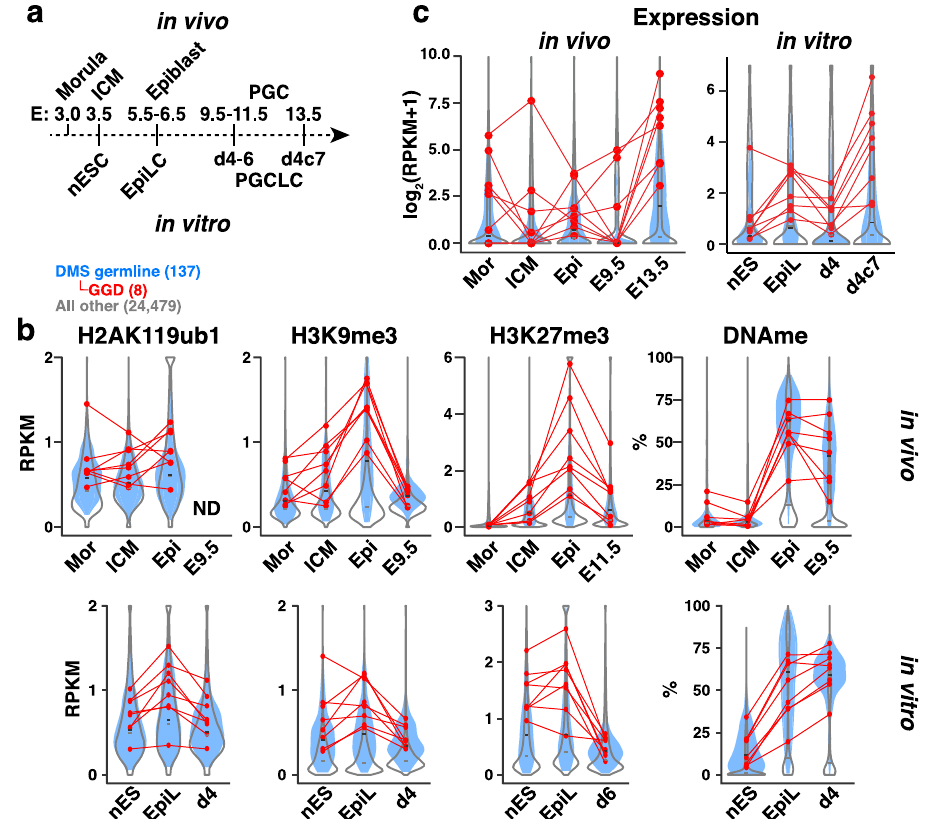
Fig. 3 H2AK119ub1 and H3K9me3 precede DNAme at DMS germline genes during embryonic development and EpiLC induction. a Application of an in vitro differentiation system to model pre-implantation (ICM), post-implantation (epiblast) and primordial germ cell (PGC) development. Naïve (n) ESCs (cultured in 2i), EpiLCs, day (d) 4 – 6 and d4 plus 7 days of culture (d4c7) PGCLCs correspond to embryonic day (E) 3.5 inner cell mass (ICM), E5.5-6.5 epiblast (Epi), E9.5-11.5, and E13.5 PGCs, respectively. b Violin plots showing in vivo and in vitro dynamics of H2AK119ub1, H3K9me3, and H3K27me3 enrichment (TSS ±2 kb) as well as DNAme levels (TSS − 0.9/ + 0.4 kb) at 137 DMS germline (blue fi lled), 8 GGD (red data points) and all other gene loci (open). ND = no data. CUT&RUN and ChIP-seq data are presented as RPKM values. Epi = E6.5 epiblast. c Violin plots showing gene expression (log 2 (RPKM + 1)) during embryonic development (in vivo) and in vitro, labeled as shown in panel ( a ). Epi = E5.5 epiblast. See Supplementary Data 2 for details of published datasets